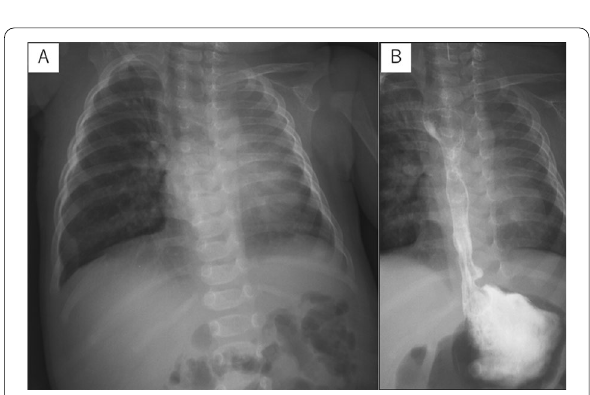
Fig. 4 Postoperative chest radiography showing a well aerated left lung ( A ). Esophagography showing satisfactory passage at the anastomotic site ( B